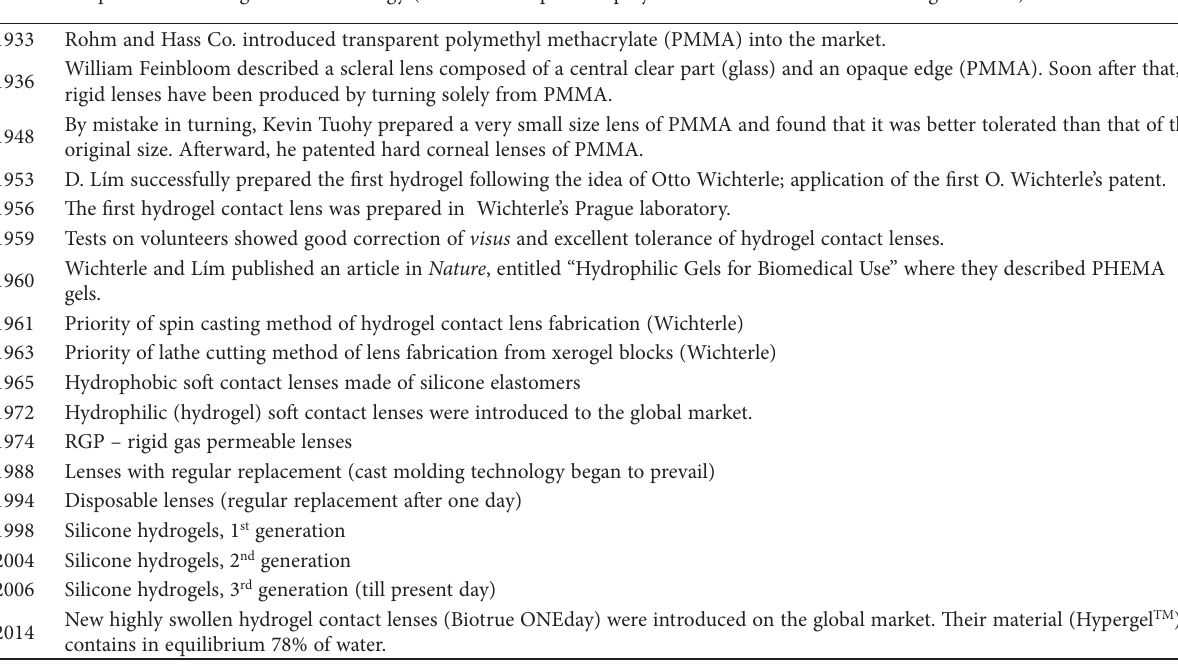
Table II. Important dates in global contactology (from the viewpoint of polymer materials and manufacturing